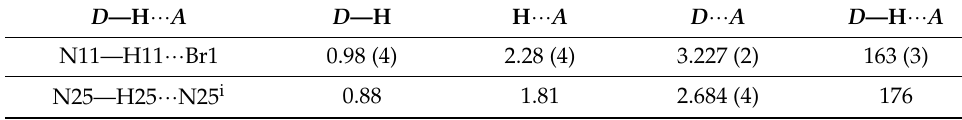
Figure 10. The intermolecular hydrogen bonds in compound 3 . Figure 11. The crystal packing of 3 , viewed along the b-axis.